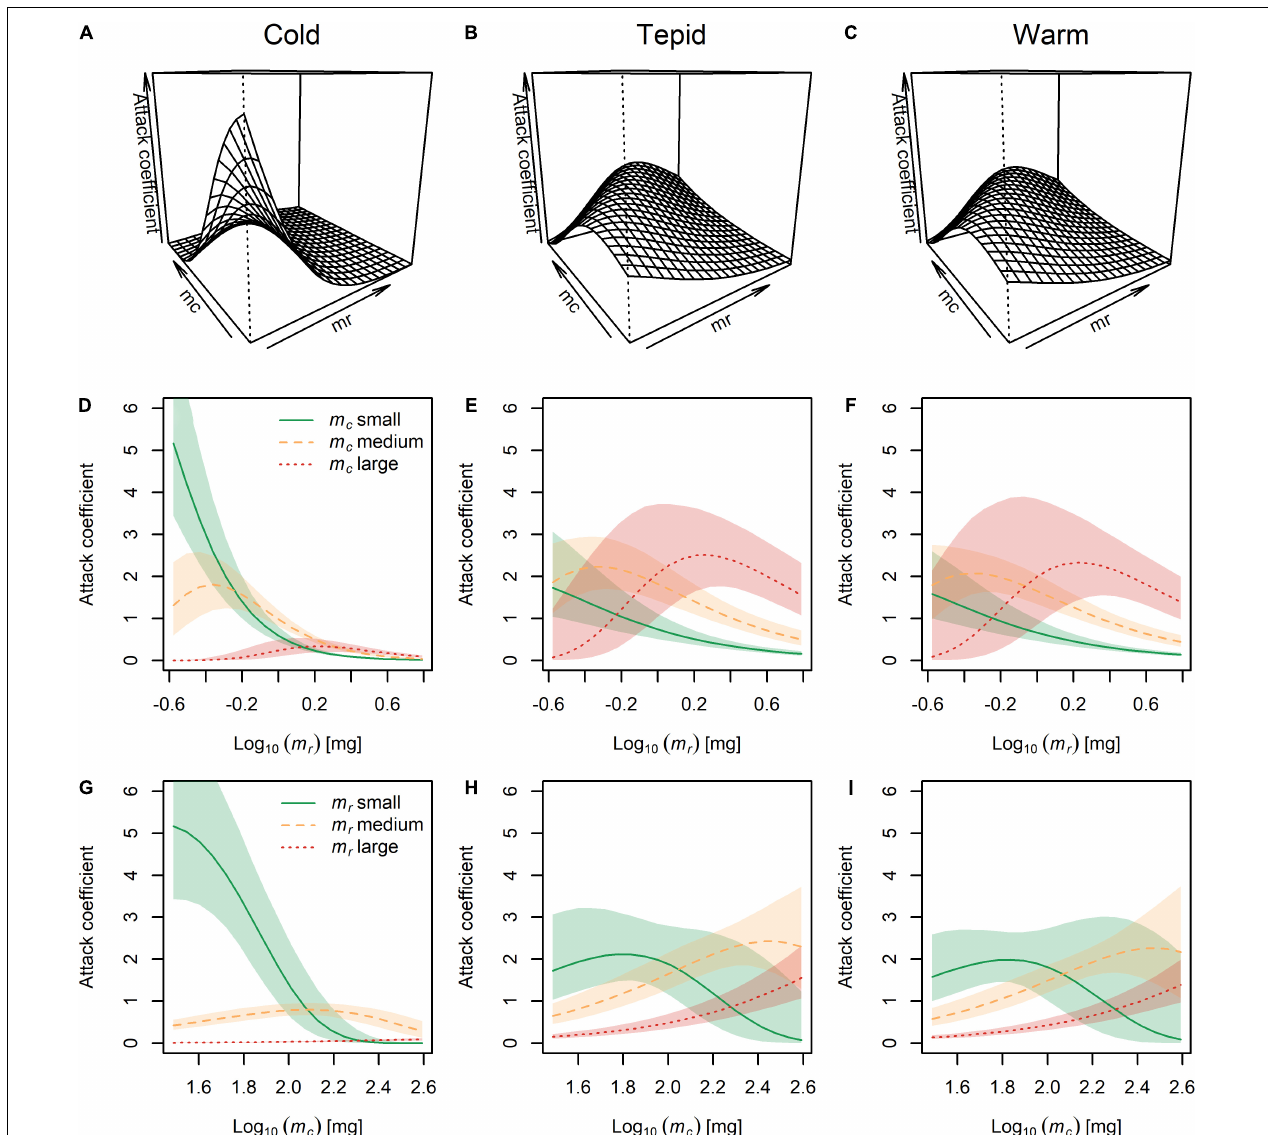
FIGURE 3 | The combined effects of temperature and body mass of the predator ( m c ) and prey ( m r ) on the attack coefficient. (A–C) Three-dimensional visualization of attack coefficients across the full range of predator and prey body masses at each experimental temperature. (D–F) Attack coefficients for small, medium, and large predators across the full range of prey body masses at each temperature. (G–I) Attack coefficients for small, medium, and large prey across the full range of predator body masses at each temperature. Lines represent the model fit and shaded areas are the Bayesian 95% posterior probability